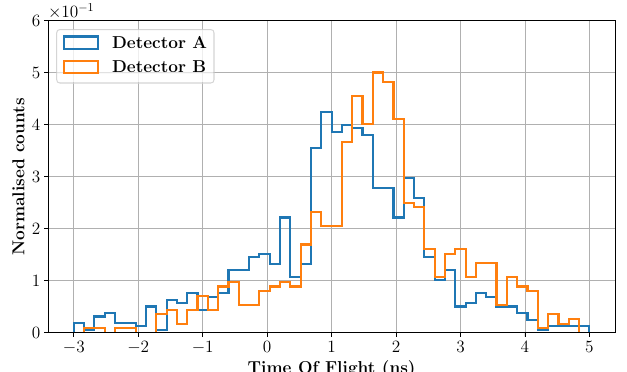
Figure 10. TOF distributions obtained with the thick PMMA target and with detector A (in blue) placed at 157 ◦ and detector B (in red) placed at 90 ◦ from the beam direction. The relevant signal is in the region between 0.5 and 3 ns. Outside this region, the background is mainly due to random coincidences caused by the limited size of the beam monitor. The two bumps located at (−1.0 distributions, respectively, are associated to protons scattered in the beam detector.